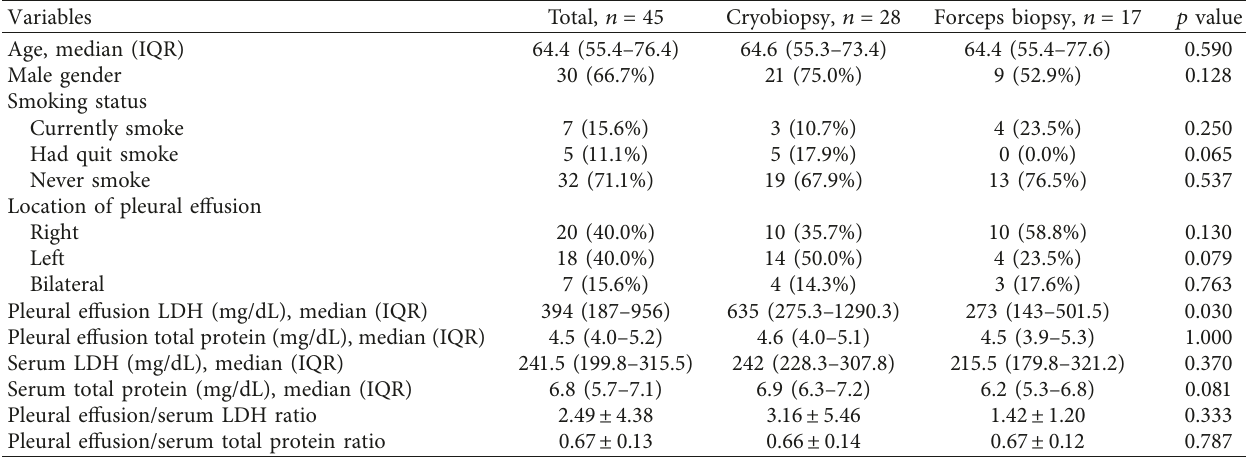
Table 1: Baseline characteristics of the study